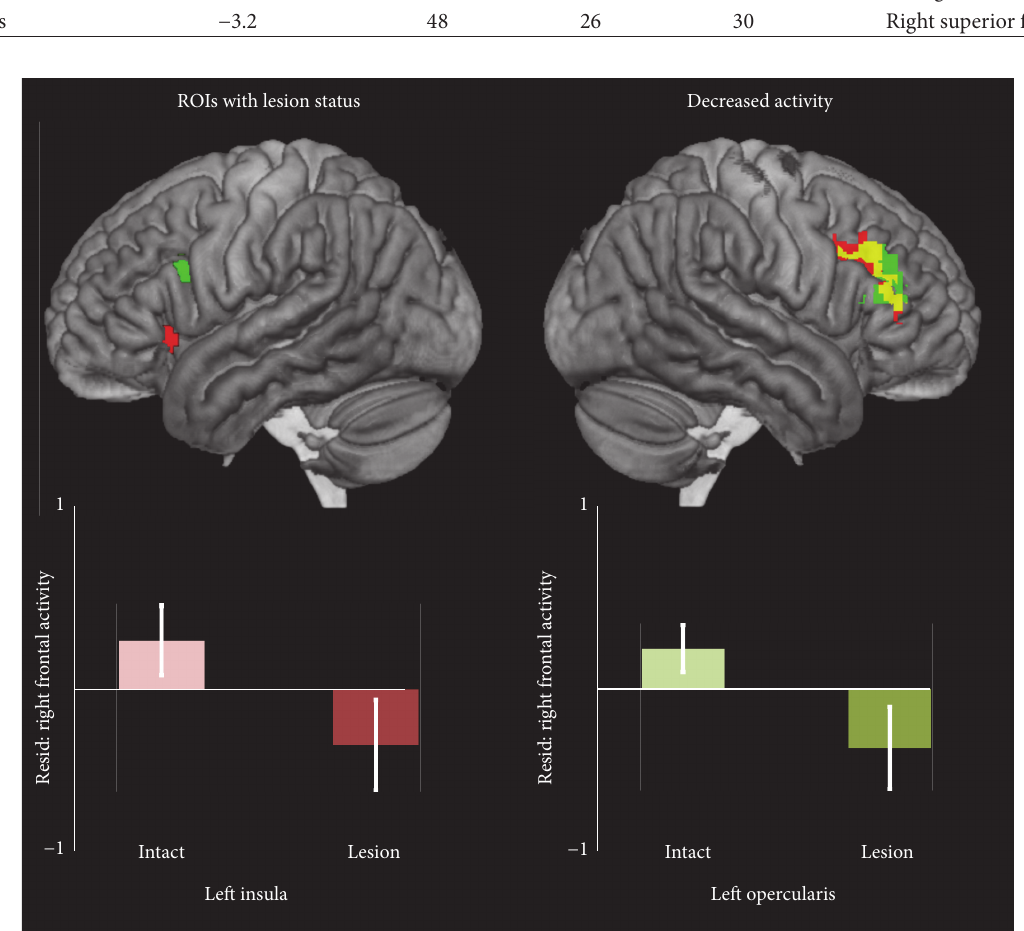
Figure 3: Lesions in the left insula and left opercularis were associated with less activity in the right middle frontal gyrus and right pars triangularis. Bar graphs show activity level in the right ROIs relative to the control sample, controlling for lesion